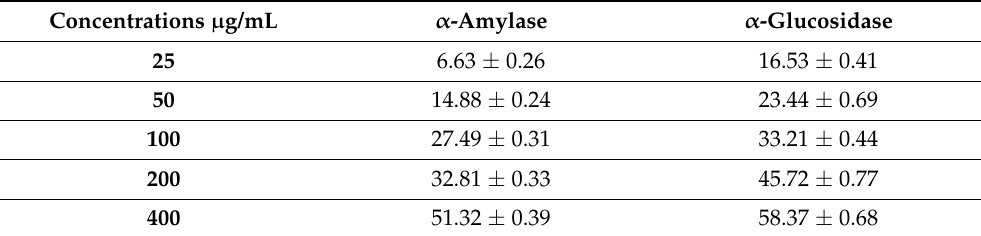
Table 7. Anti-diabetic efficacy of synthesized of